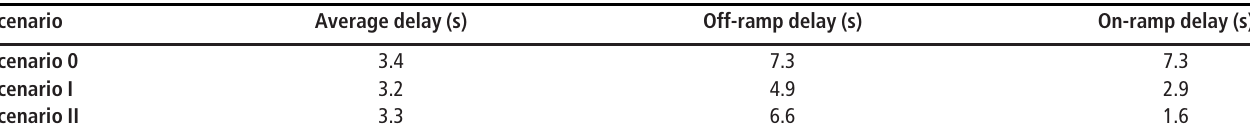
Table 1 Average delays in different simulation